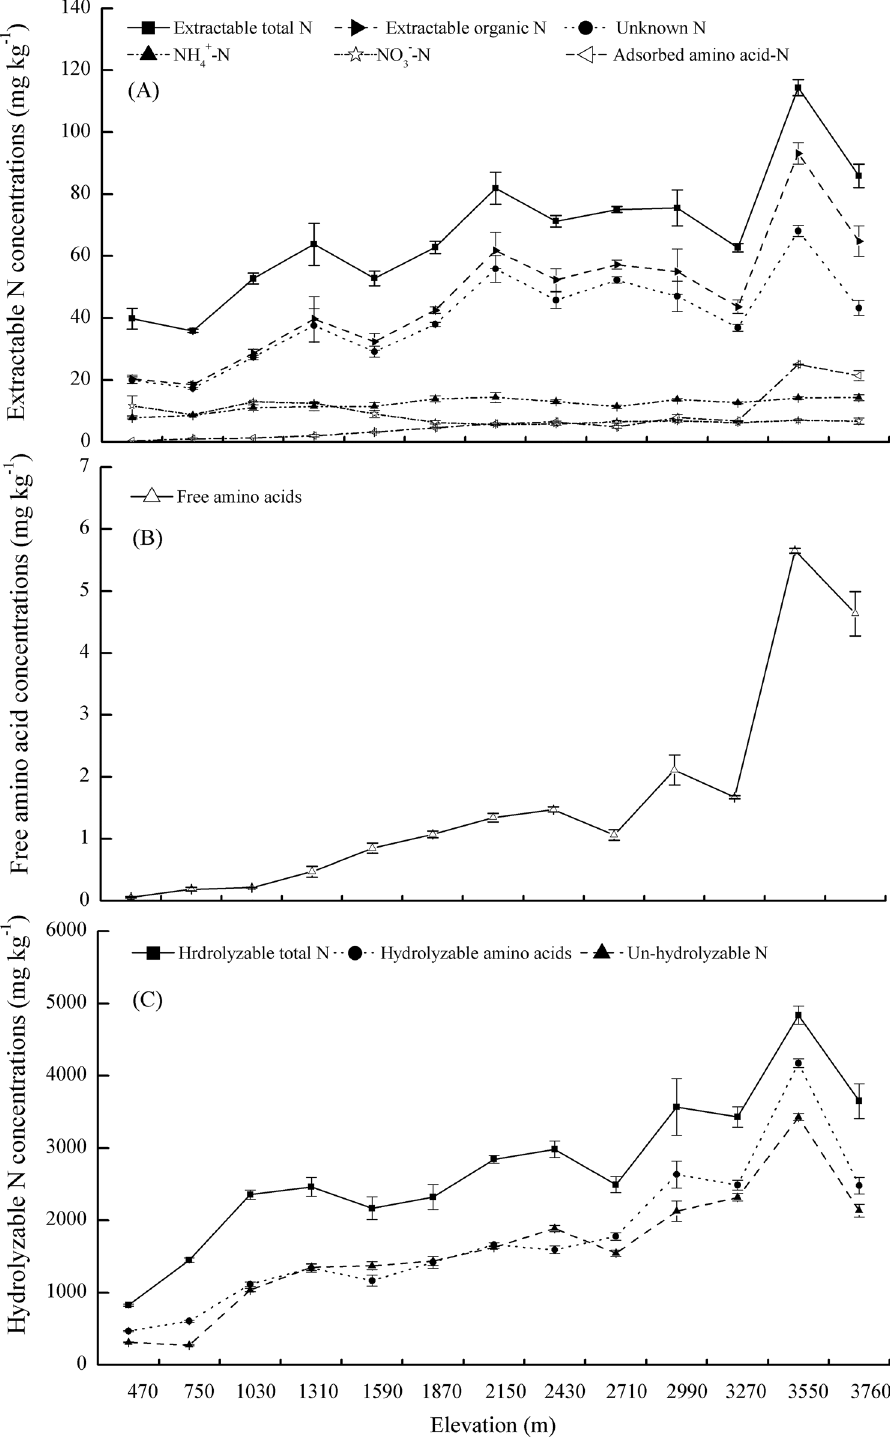
Fig 1. Concentrations of the different extractable N forms (A), free amino acids (B) and different hydrolyzable N forms (C) in the thirteen sampled elevations. Error bars represent standard error (n = 3).